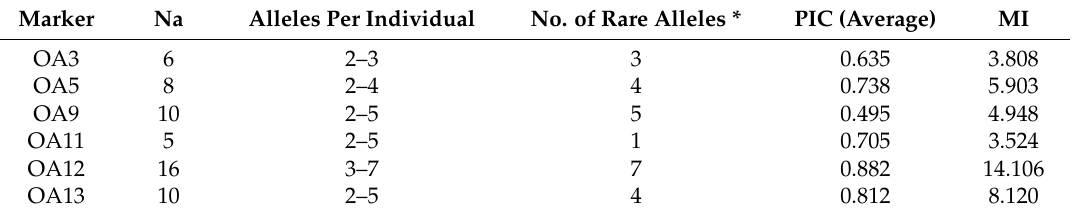
Table 2. Number of alleles (Na), alleles per individual, number of rare alleles, polymorphic information content (PIC), and marker index (MI) values for the 6 SSR primer pairs studied. Marker Na Alleles Per Individual No. of Rare Alleles * PIC (Average) MI